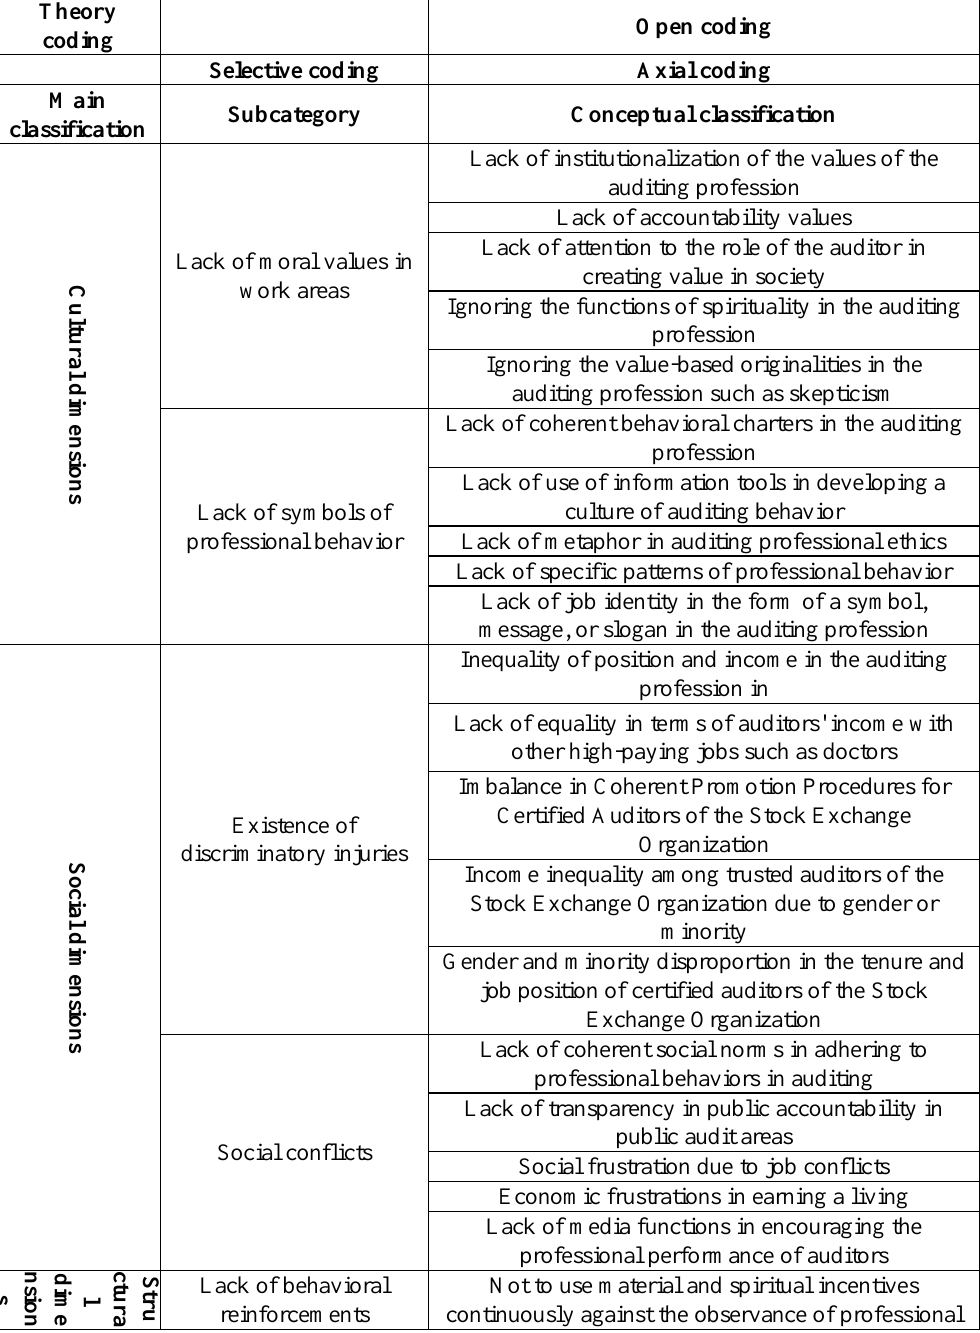
Table 4. Conceptual and categorical codes resulting from the interviews